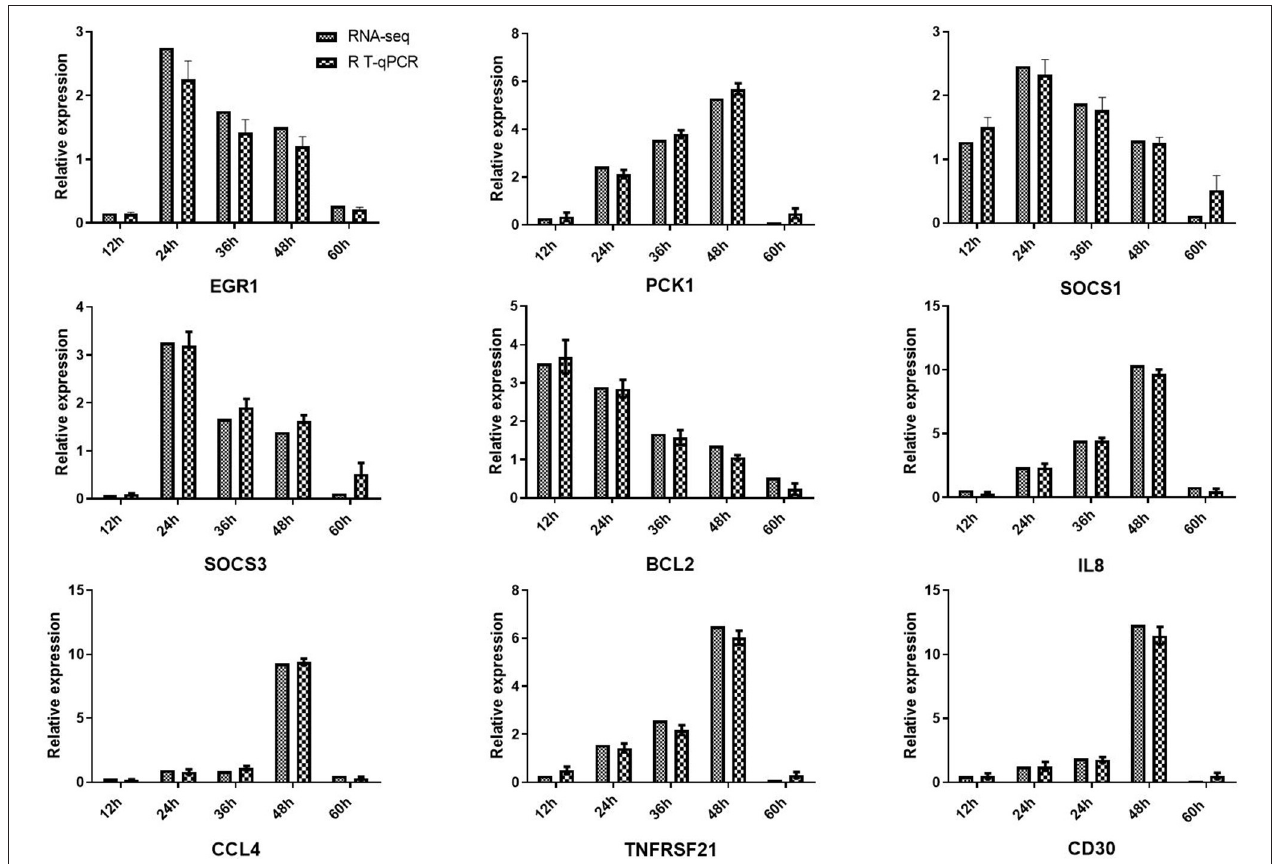
FIGURE 6 | Validation of RNA-seq results using quantitative reverse-transcription PCR (qRT-PCR). Expression profiles of nine DEGs playing important roles in viral defense. qRT-PCR verified that mRNA levels of these genes were increased after viral infection, consistent with the altered expression profiles observed in transcriptome data. β -actin was used for normalization. The x-axis represents the different time points, and the y-axis represents the normalized fold-change of